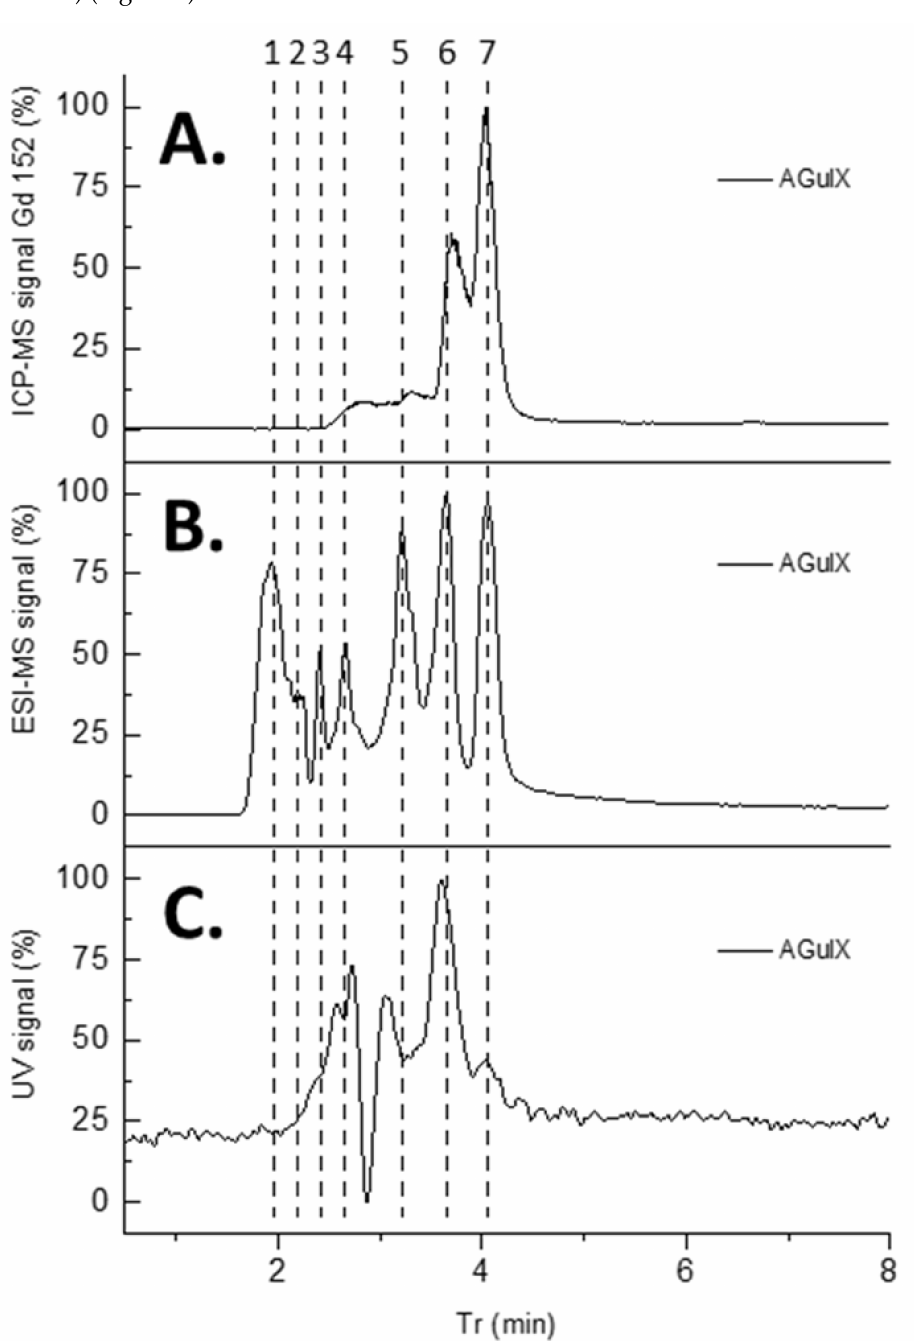
Figure 2. ( A ) LC-ICP/MS chromatogram of AGuIX’s fragments (3 µ L, 1 g/L) recorded at Gd 152